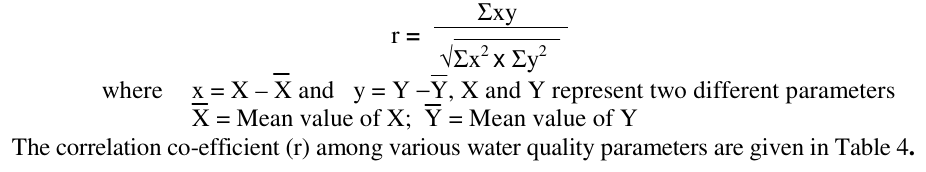
Table 4. Correlation matrix for the water quality